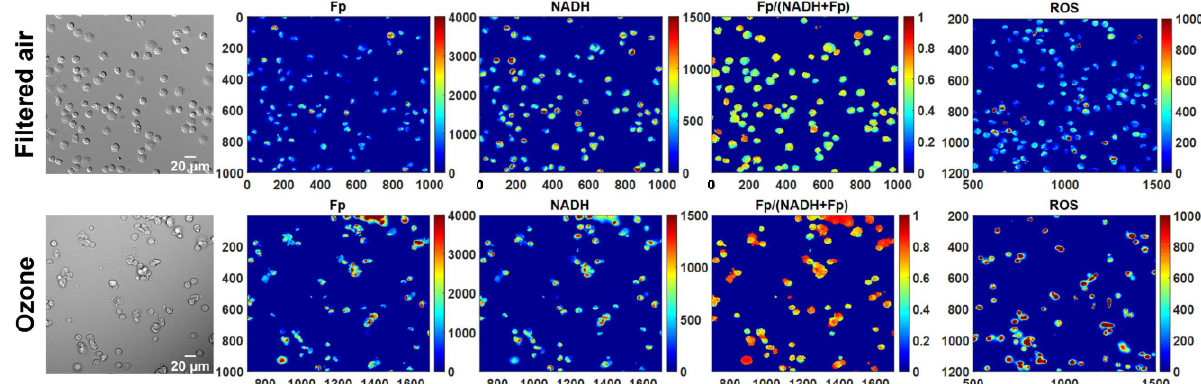
Figure 1. Representative white light and the corresponding redox images of the same field of view for filtered air or ozone exposure, respectively. Remarkable morphological changes can be readily observed in AM from KO mice exposed to ozone, consistent with those observed from freshly isolated AM from ozone-exposed KO mice. The x and y axes are coordinates of the redox image matrices. Numbers and color bars on the right of each redox image indicate the range of the index being displayed. Note that the ROS images are not in the same field of view as the white light and redox images under FA or ozone exposure, respectively; however, they are from the same animal and cultured in the same dish.